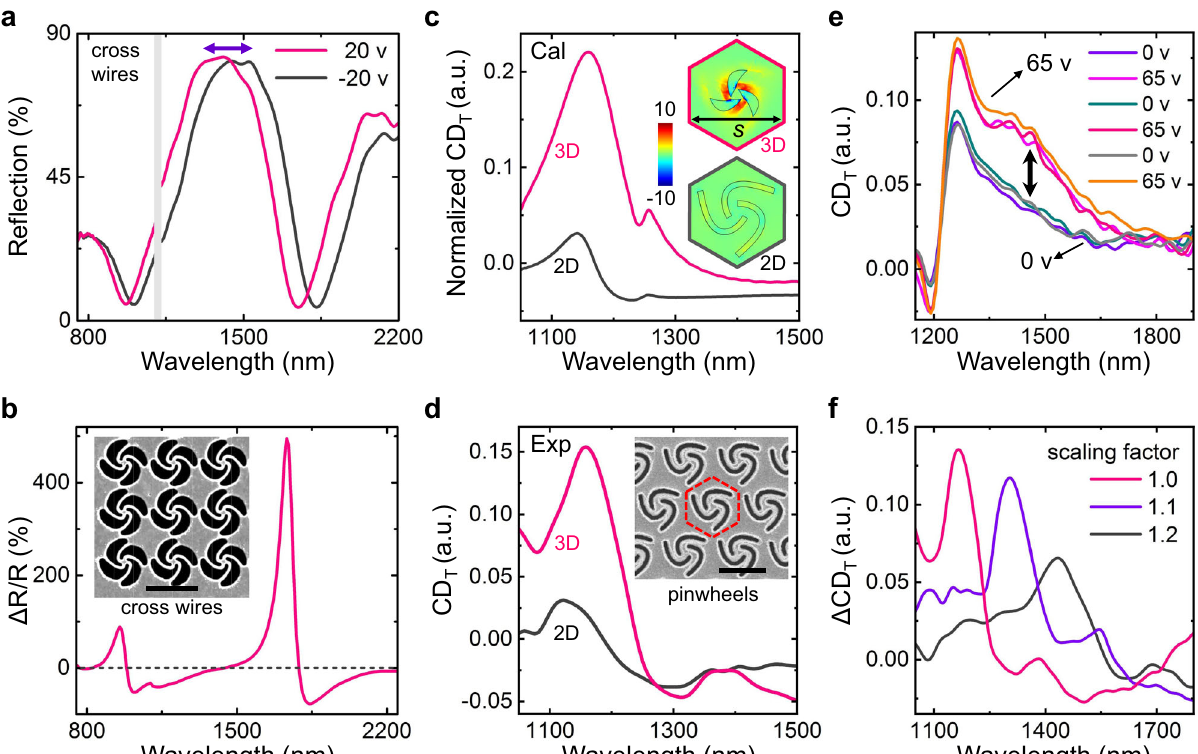
Fig. 4 Submicron nano-kirigami and recon fi gurable helicity. a Measured re fl ection spectra of the cross wires in the inset of b , which are switchable between V = 20 and − 20 V. b Measured modulation contrast in re fl ection spectrum for the cross wires in the inset. Structural parameters: w = 0.796 µ m, p = 0.975 µ m, d = 200 nm. c , d Simulated and measured CD spectra of initial 2D and deformed 3D three-arm pinwheels [de fi ned as CD (a.u.), see “ Methods ” ] at V = 0 and 60 V, respectively. To compare the changes induced by 3D deformations under the same starting condition, the simulated CD spectrum of the initial 2D pattern is normalized to the experimental spectrum of the same structure. Inset of c , calculated distribution of enhancement factor of optical helicity density for 2D (left, at z = 0 plane) and deformed 3D (right, at z = − 120 nm plane) pinwheels in hexagonal unit cells under RCP incidence (Supplementary Fig. 10b, c). Inset of d , SEM image of the fabricated 2D pinwheels with scaling factor of 1.0. Structural parameters: w = 0.880 µ m, pinwheel spacing s = 1.15 µ m, d = 300 nm. e Measured CD spectra of three-arm pinwheels with s = 1.265 μ m when the voltage is switched between 0 and 65 V (see Supplementary Fig. 10f). f Measured changes in CD spectra ( Δ CD T ¼ CD T ; 3D (cid:2) CD T ; 2D ) between 3D and 2D three-arm pinwheels under scaling factors of 1.0 (red), 1.1 (blue), and 1.2 (black). Scale bars: 1 μ